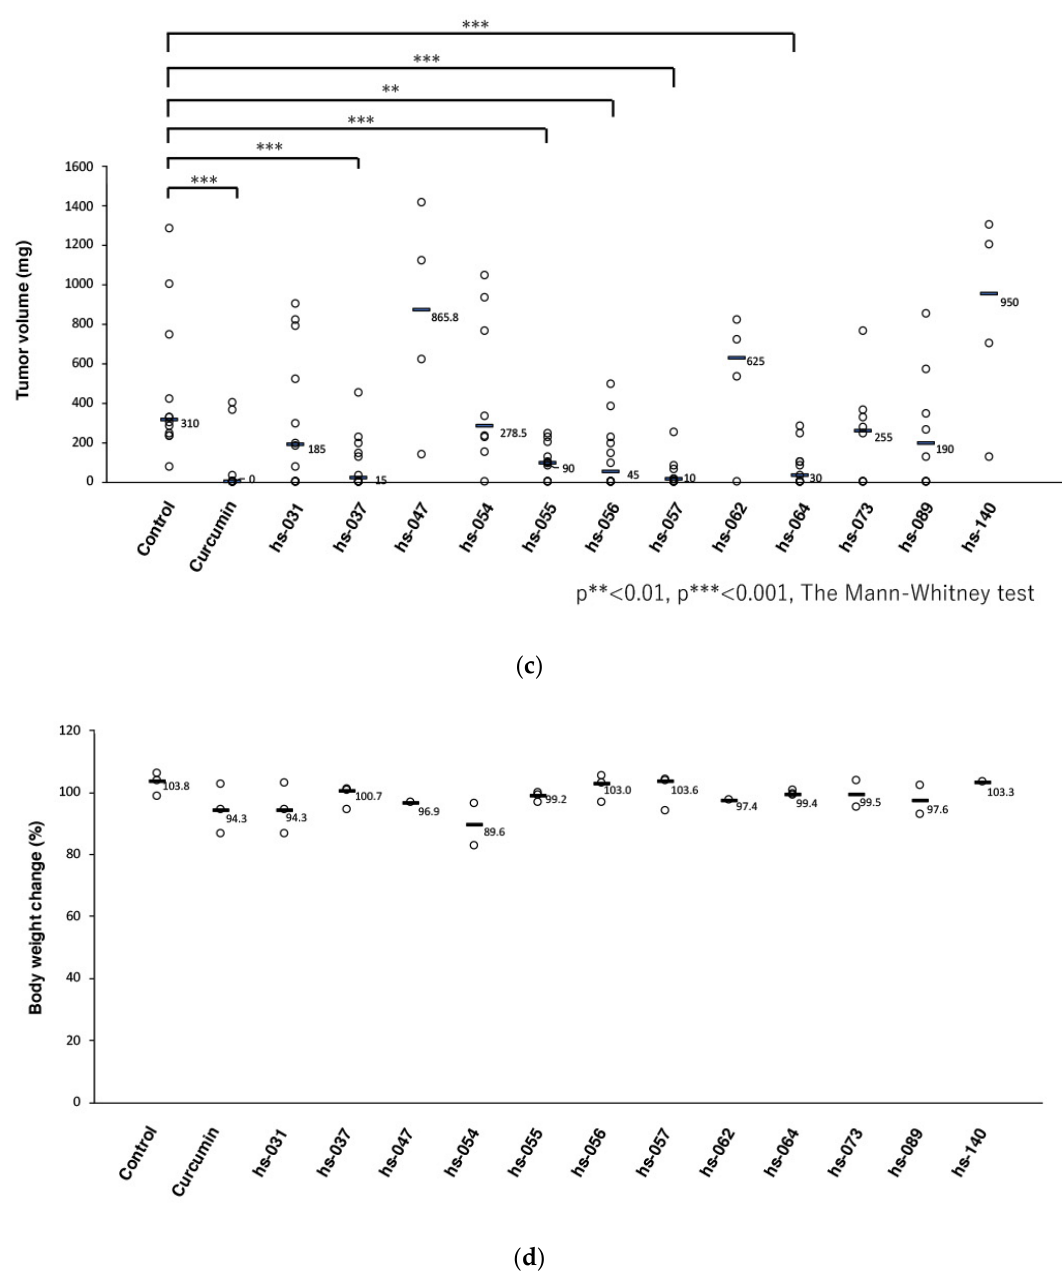
Figure 4. Inhibition of tumor formation by curcumin derivatives. ( a ) K562 cells (2.5 × 10 6 cells) were transplanted s.c. into the flanks of nude mice. Mice were then treated with curcumin derivatives (25 mg / kg BW) in corn oil and vehicle (corn oil) via an i.p. injection every 2 days. The tumor sizes were measured every 2 days. ( b – d ) After 18 days post-injection, mice were sacrificed, tumors were taken ( b ), and tumor weights ( c ) and the body weights ( d ) were measured.